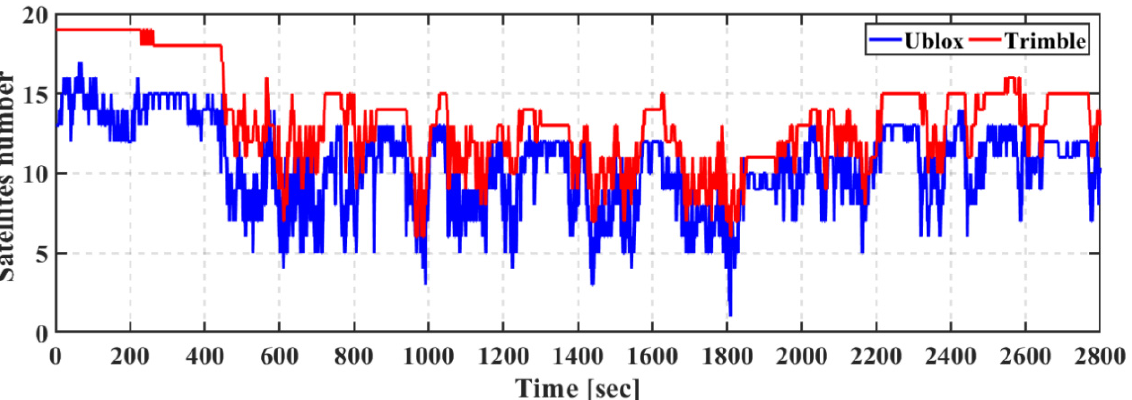
Figure 11. Second field trial: Number of tracked GPS, GLONASS, and Galileo satellites.